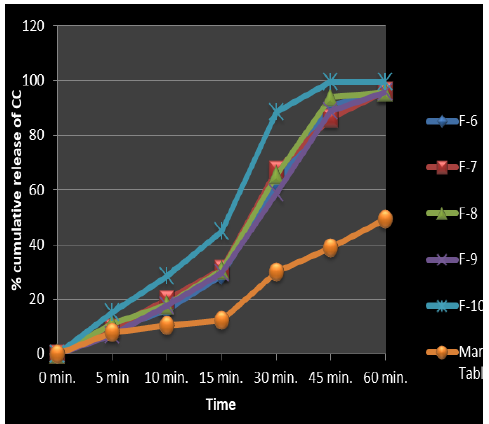
Figure 6. Comparative dissolution profile for formulas (F-6 to F-10) and marketed tablet of CC. in 0.1N HCl (pH 1.2) with 0.5 % tween 20 at 37 °C. Table 8. Release kinetic of CC SEDDS formulations. Formula